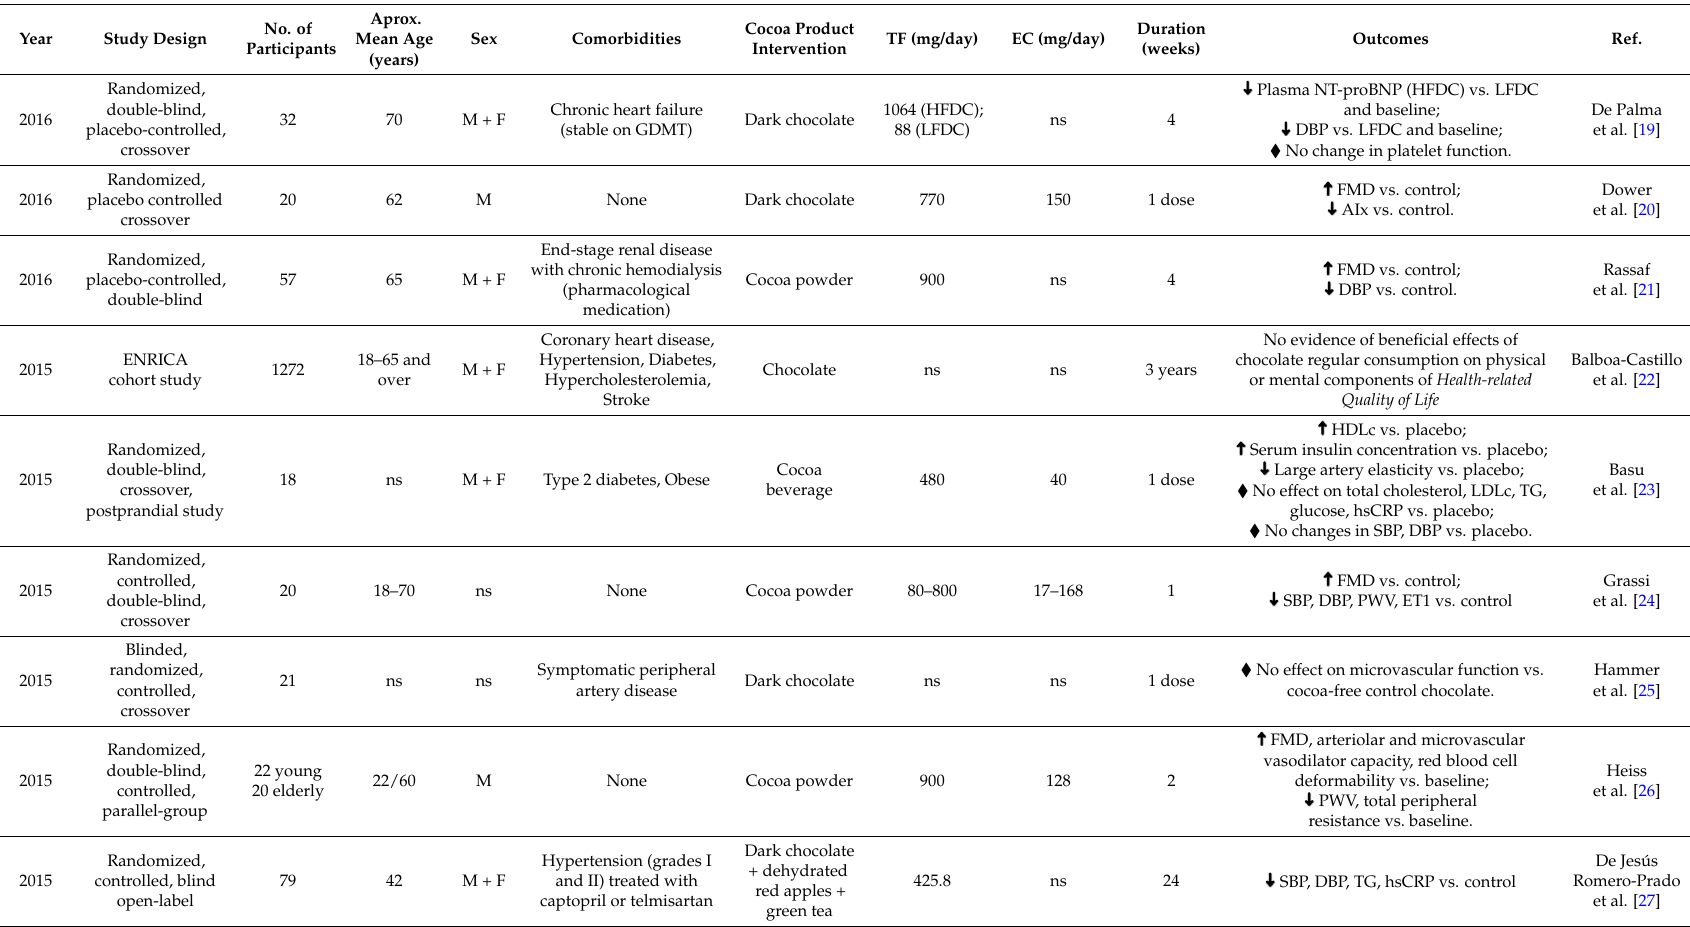
Table 1. Outcomes of recent (2014–2016) clinical trials of cocoa products.